Question: Sum up the contents of this chart in one sentence.
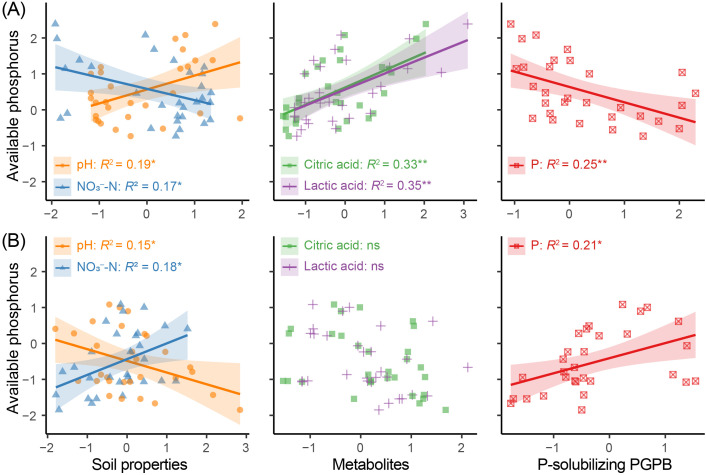
Answer: Linear relationships between soil available phosphorus and chemical properties, metabolites, and phosphate-solubilizing PGPB. (A) Soybean; (B) Suaeda salsa . Data were z-score normalized. *, **, and ns denote significance at p = 0.05, p = 0.01, and non-significance, respectively.